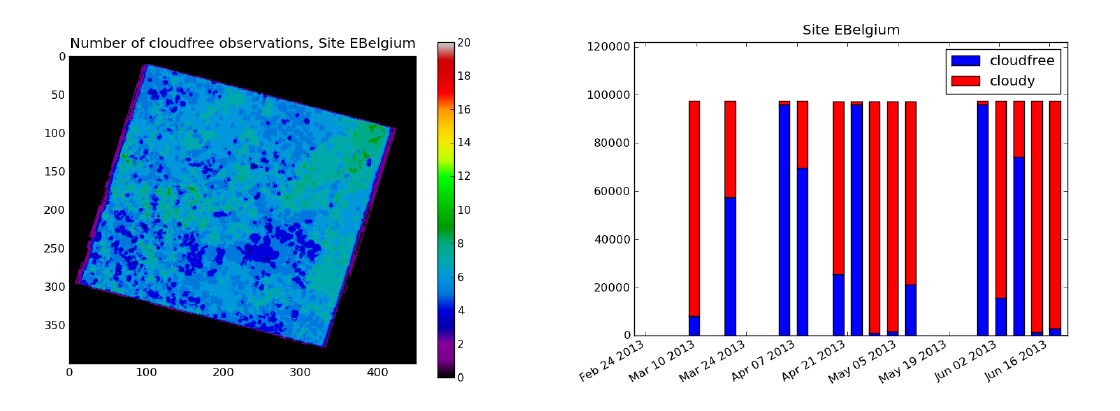
Figure 7. The left plot shows a map of the number of cloud-free observations (between four and nine), according to the Multi-sensor Atmospheric Correction and Cloud Screening (MACCS) cloud mask, for the site in Belgium, from February–June 2013. The plot on the right shows in blue the percentage of cloud-free pixels for each date. The missing dates are dates with too few cloud-free pixels to allow the ortho-rectification. It should be noted that on that site, the first image of this site with a sufficient number of cloud-free pixels to allow the L1C processing was obtained on 10 March, six weeks after the start of the